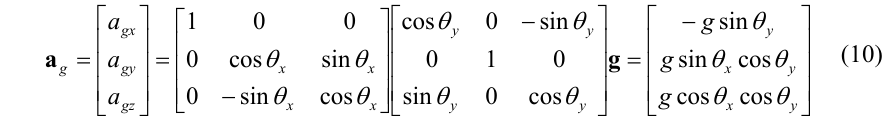
Fig.2 Rotation of a rigid body in X-Y-Z reference frame Then, if only the acceleration of gravity is considered, and the rigid body rotates about Y axis at first, and then about X axis, the gravitational acceleration components about each sensitive axis are shown as follows: